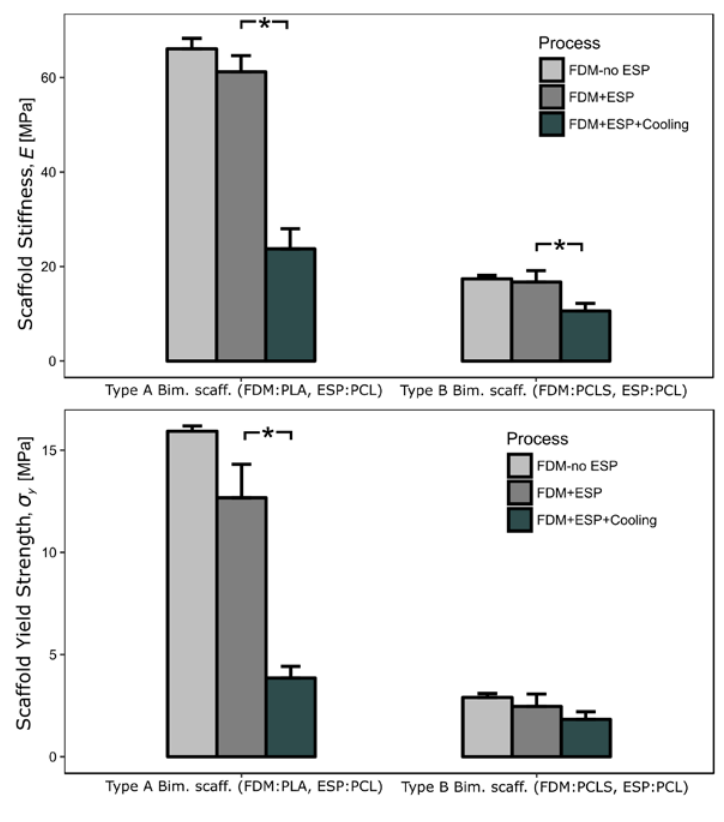
Figure 6. Mechanical properties of bimodal scaffolds (scaffold stiffness and scaffold yield strength). Note: * means p -value < 0.05.